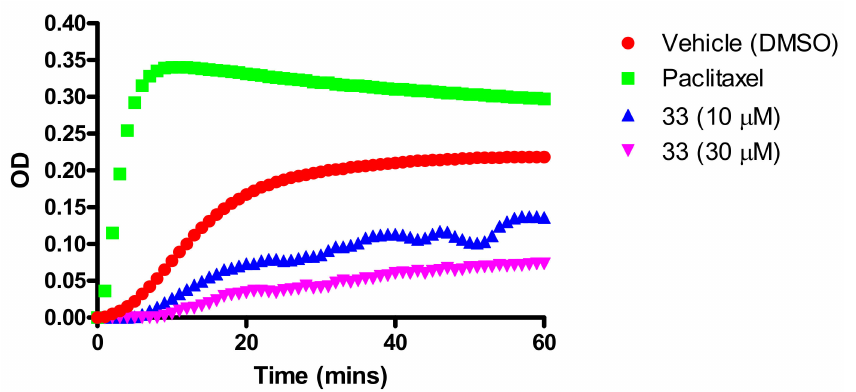
Figure 7. Effect of β -lactam compound 33 (10 and 30 µ M) and paclitaxel (10 µ M) on in vitro tubulin polymerisation. Purified bovine tubulin and GTP were mixed in a 96-well plate. Compounds were added and the reaction was started by warming the solution from 4 to 37 ◦ C. Ethanol (1% v / v ) was used as a vehicle control. The effect on tubulin assembly was monitored in a Spectramax 340PC spectrophotometer at 340 nm at 30 s intervals for 30 min at 37 ◦ C. The graph shows one representative experiment. Each experiment was performed in